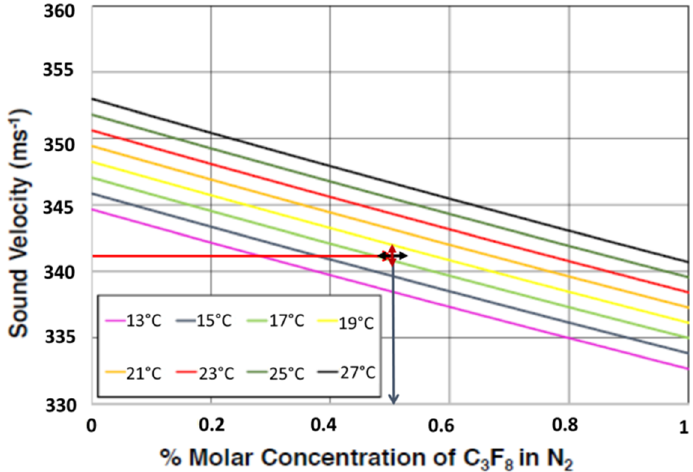
Figure 6. Variation of sound velocity with concentration of binary C 3 F 8 /N 2 mixtures in the range 0 → 1% C 3 F 8 at 1 bar abs . The added vertical and horizontal indicators illustrate the relation between the uncertainties in measured sound velocity and mixture determination [1].